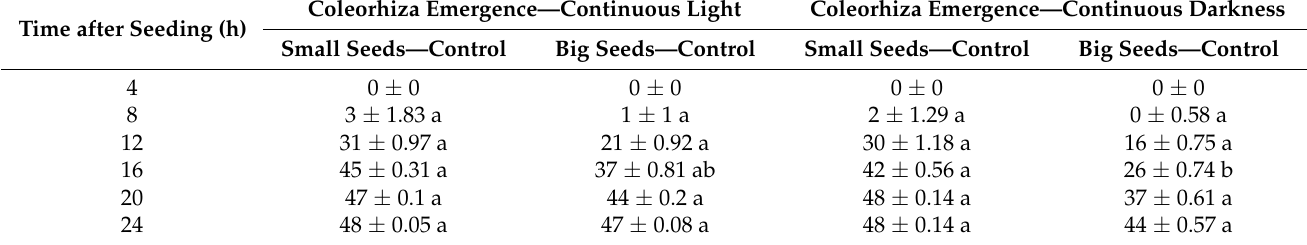
Table 1. Effect of seed size of winter wheat and light conditions (continuous light and darkness) on the kinetics (expressed as time in hours) of coleorhiza emergence during germination of control samples (without EMF treatment).